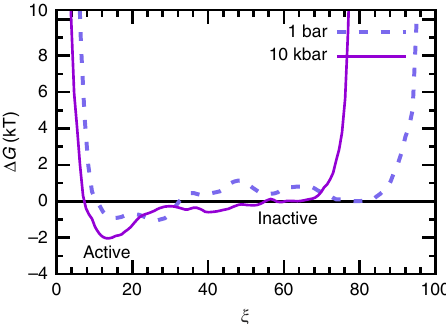
Figure 6 | Minimum free-energy pathways connecting active and inactive configurations. Minimum free-energy pathways connecting the active to the inactive basin of AP configurations according to the landscapes in Fig. 5a,b corresponding to ambient and high pressure at 300K, respectively; free energies are reported relative to the inactive